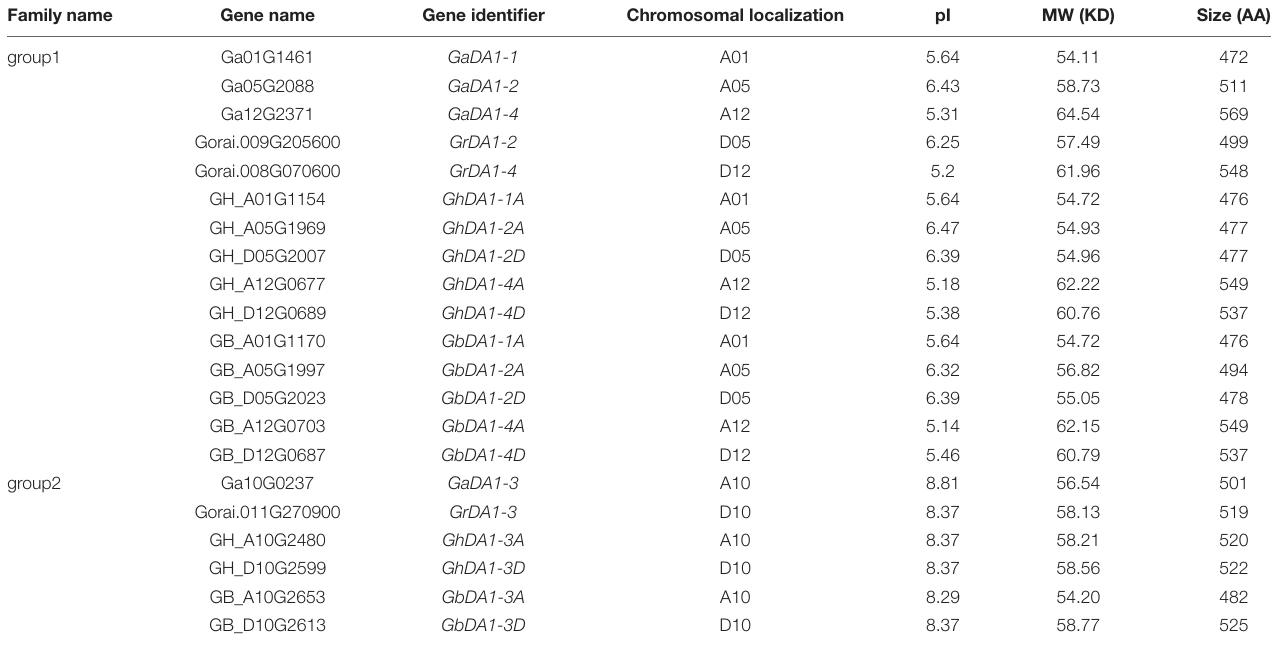
TABLE 1 | Characteristics of DA1-like genes and predicted properties of DA1-like